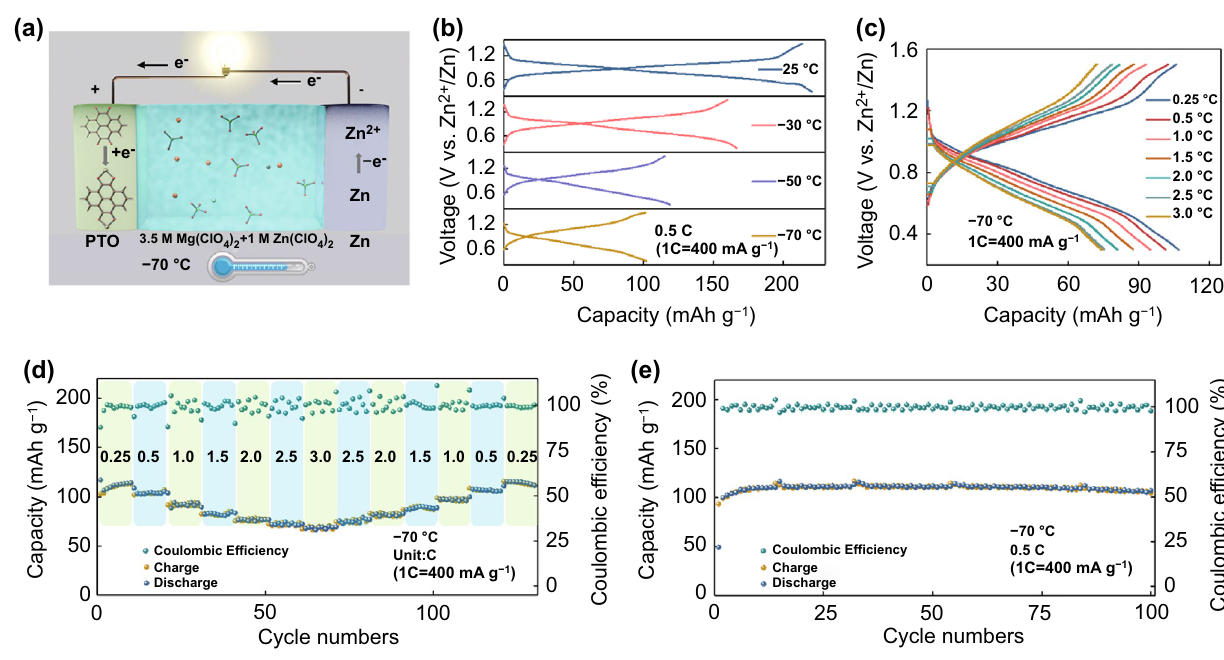
Fig. 4 a Schematic of low-temperature Zn||PTO battery. b Charge–discharge curves of Zn||PTO battery at different temperatures. c Charge–dis- charge curves of Zn||PTO battery at different current density. d Rate capacity of Zn||PTO battery at − 70 °C. e Cycling stability of Zn||PTO